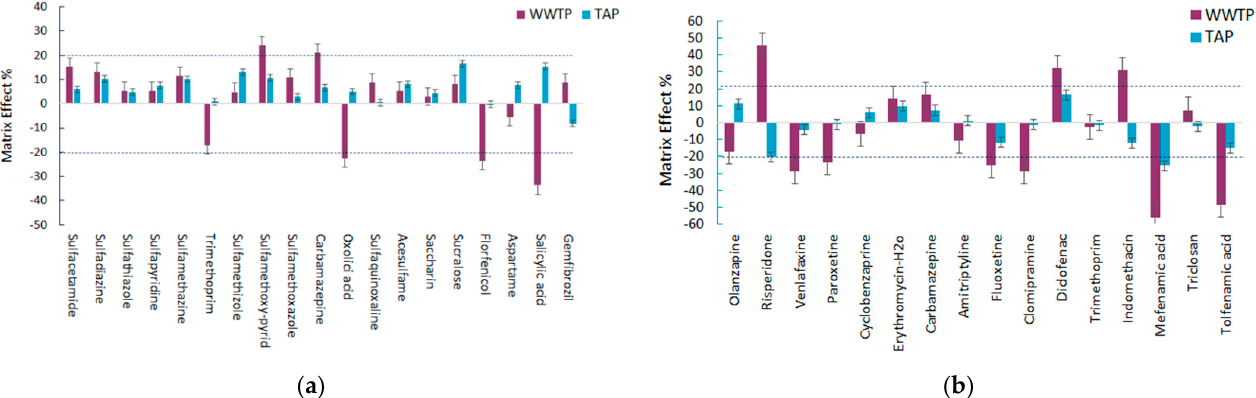
Figure 12. Matrix effect for the selected pharmaceuticals in the different aqueous matrices after ( a ) MSPE@Fe 3 O 4 @GO and ( b ) MSPE@SiO 2 @C18